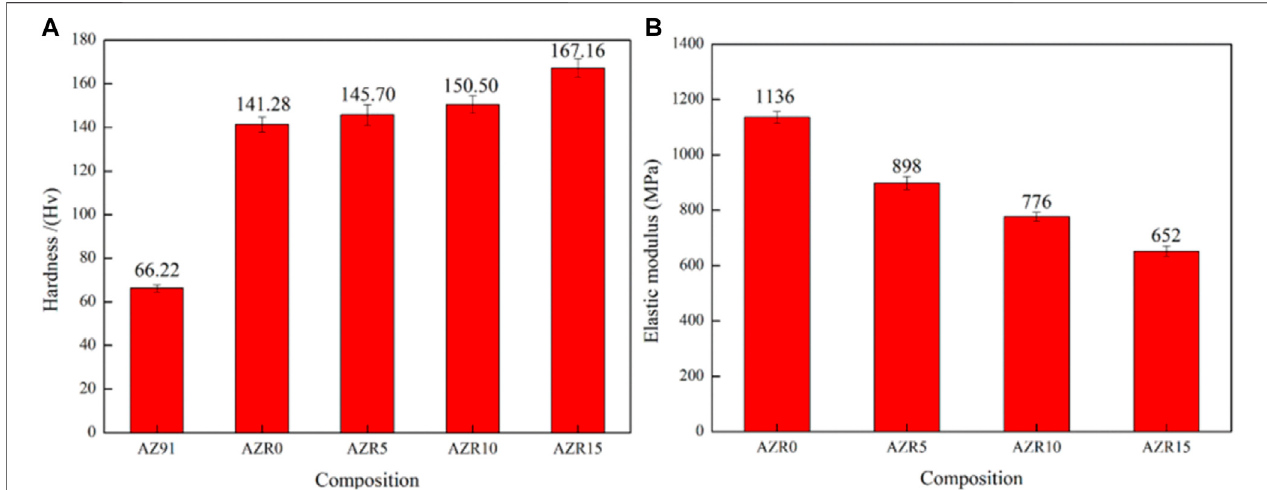
FIGURE 7 | Hardness. (A) Young ’ s modulus and (B) of MAO coating of the different samples.